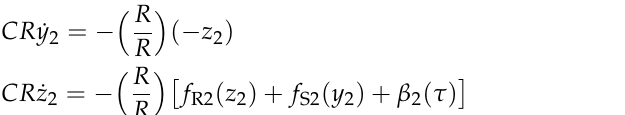
. K is the gain of a 1